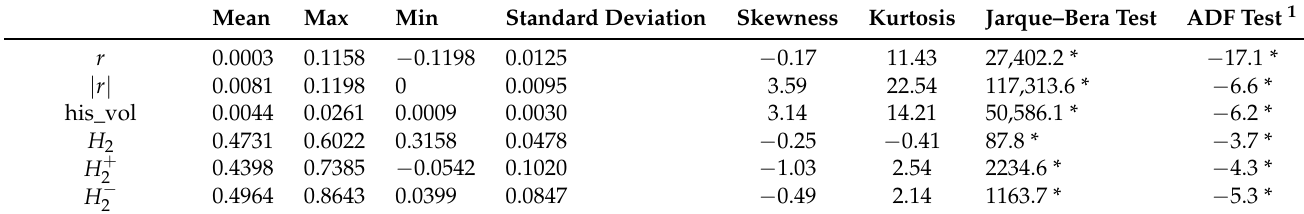
Table 2. Data statistics.